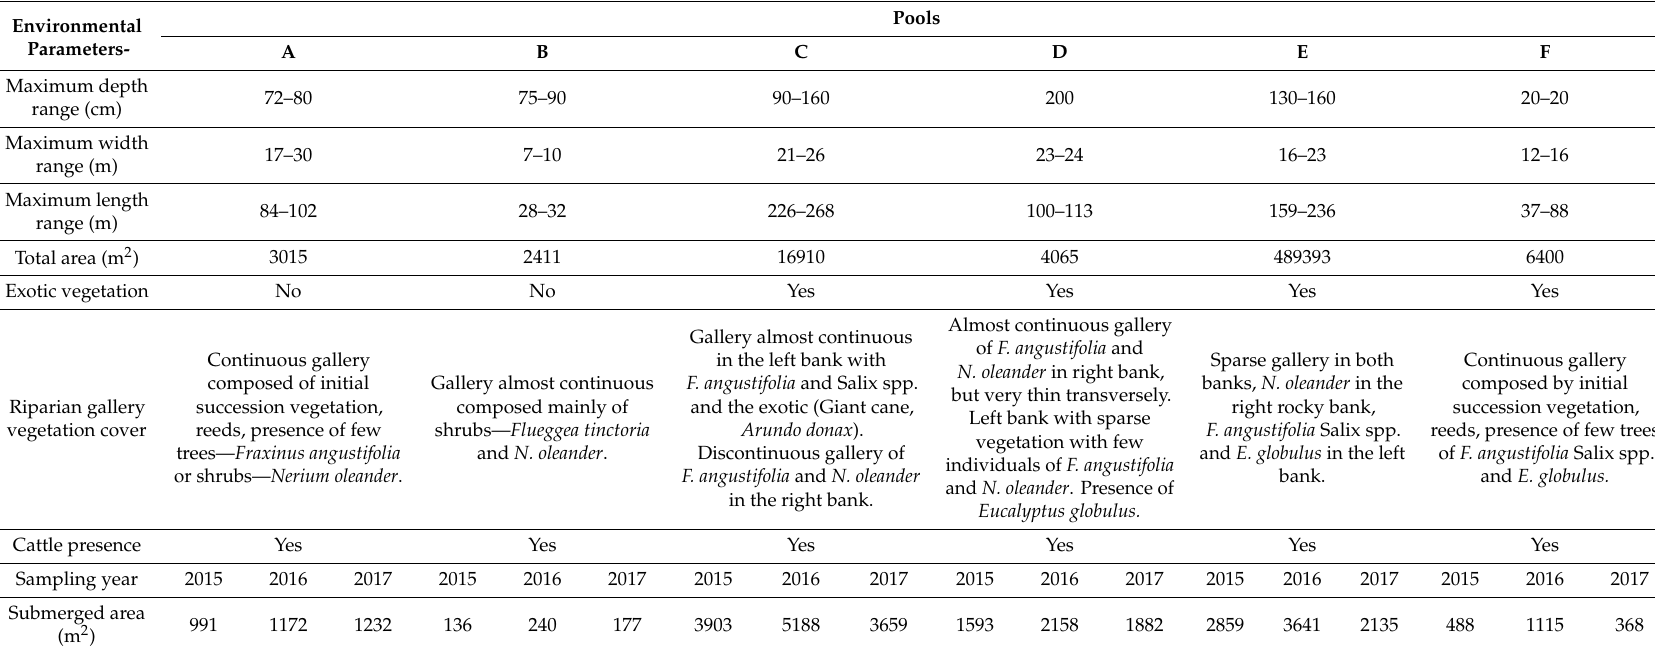
Table 1. Environmental conditions and population parameters in six pools (A to F) in the Oeiras river in